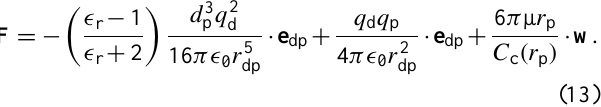
Fig. 5. Trajectories of charged aerosol particles in a laminar flow around a charged sphere. The arrows correspond to the vector field of the flow; green lines corresponds to the trajectories that lead to a collision. Temperature: 240K; droplet charge: 1.63pC; particle charge: 1e; linear velocity of the flow at infinity: 0.471ms −